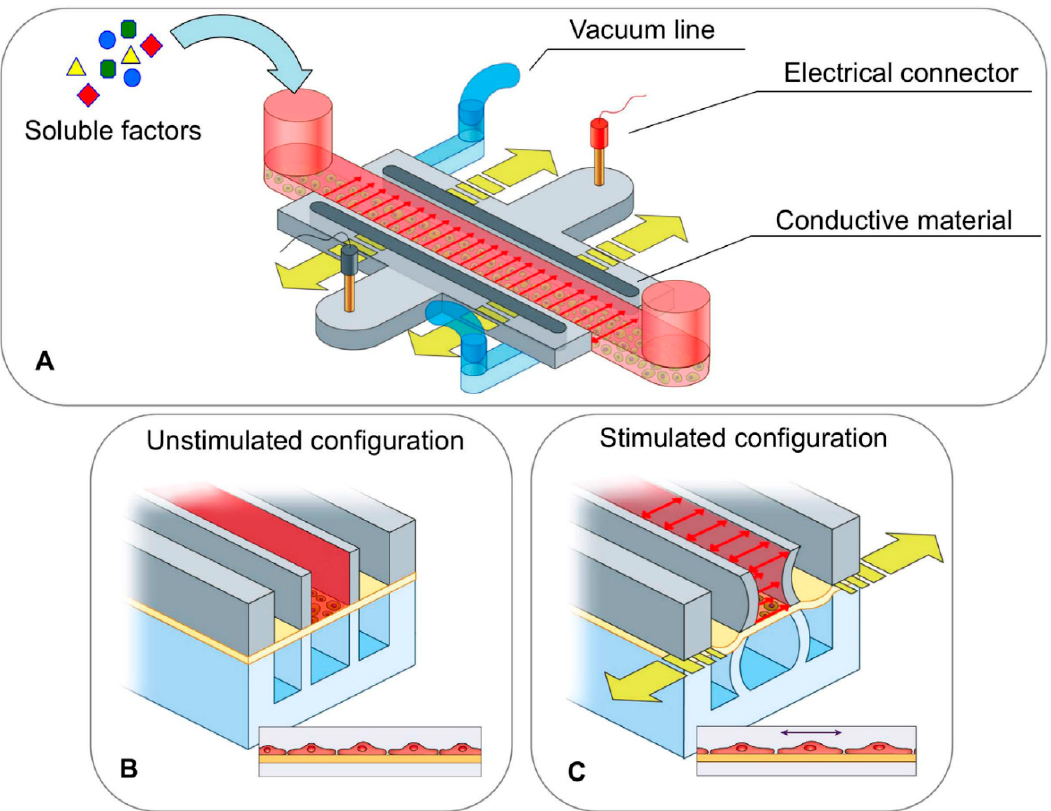
Figure 6. Microfluidic platform developed to study the effect of biochemical, mechanical and electrical stimulations for stem cell differentiation: ( A ) Schematic view; ( B ) cross-section view in unstimulated configuration; ( C ) cross-section view in stimulated configuration. The central channel (in red) is the media channel providing nutrients and soluble factors to cells. The pneumatic channels (in light blue) perform mechanical stimulation by stretching the poly(dimethylsiloxane) (PDMS) membrane (yellow arrows) where the cells are cultured. The electrically conductive layer (in light grey) is based on two regions composed of PDMS and carbon nanotubes (CNT) mixture, connected to the stimulator by two external gold-coated connectors (in red and black). Reproduced from Pavesi et al. [5]. Such physical stimulation may further enhance differentiation and reprogramming into CMs.